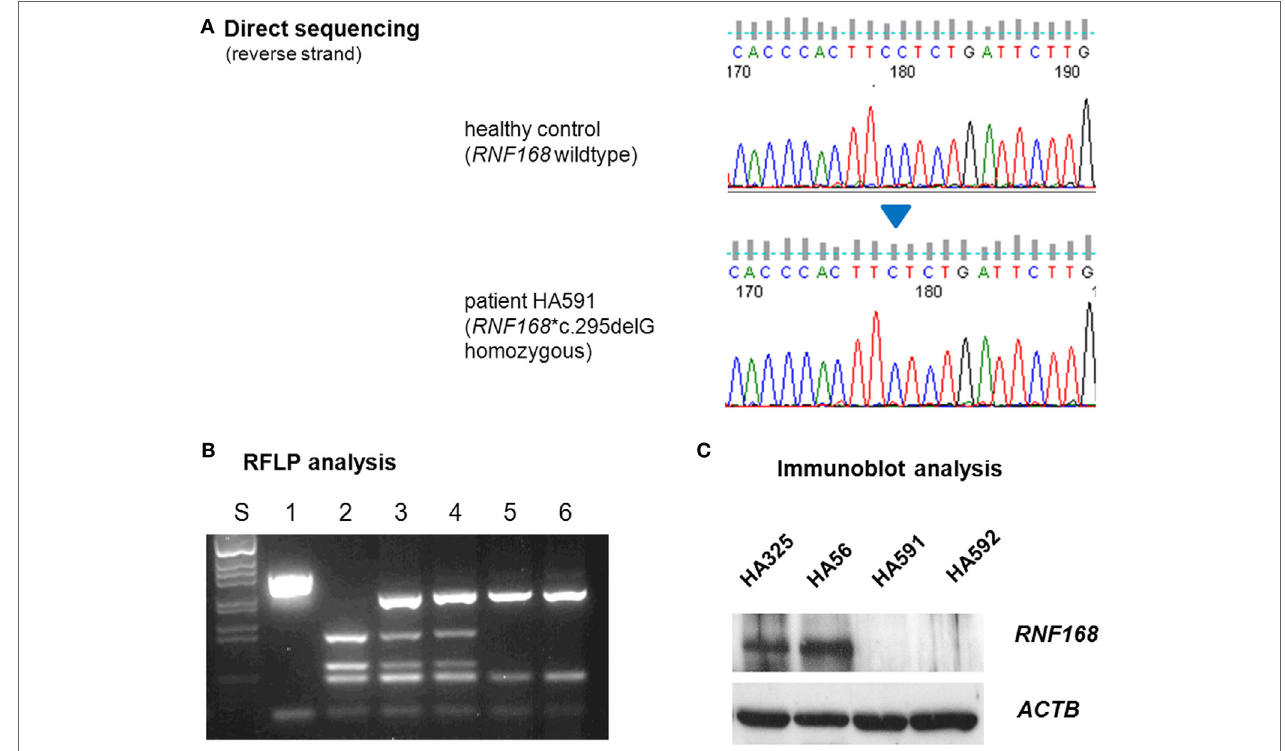
FigUre 2 | Assessment of RNF168 mutation (a) and RNF168 protein level (B) . (a) Direct sequencing of RNF168 exon 12 reveals homozygosity for the novel frameshift mutation c.295delG in genomic DNA from either of both patients (HA591, HA592). (B) RFLP analysis of PCR products on 2% agarose gel electrophoresis. S, size marker; 1, undigested PCR product; 2–6, PCR products cleaved with Mnl I: 2, wild-type control, 3, paternal sample, 4. maternal sample, 5, patient HA591, 6, patient HA592. (c) Western blot analysis reveals strongly reduced immunoreactivity for RNF168 protein in lymphoblastoid cells from either of both patients (HA591, HA592). Lymphoblastoid cell lines (LCLs) from a healthy individual were used as an RNF168-proficient control (HA325), and LCLs from a patient with classical ataxia–telangiectasia were used for comparison (HA56). β -actin served as the loading control